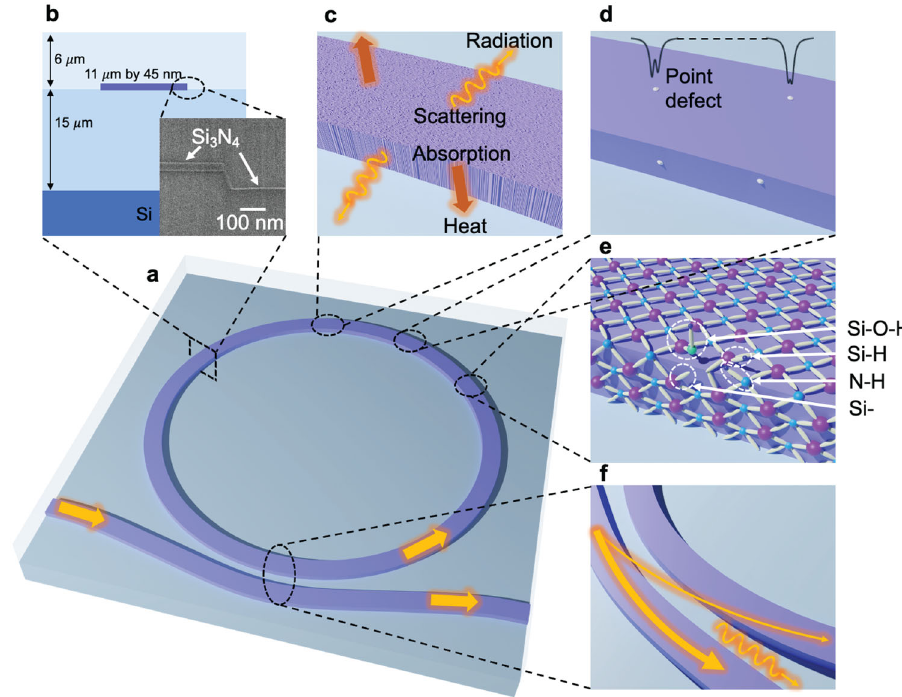
Fig. 1 Bus-coupled ring resonator and loss mechanisms. a Illustration of the resonator design. b Waveguide design. Inset scanning electron micrograph (SEM) image of the waveguide cross section with the thermal oxide bottom cladding, an etched low-pressure chemical vapor deposition (LPCVD) grown silicon nitride waveguide core, an additional thin (~5 nm) blanket layer of silicon nitride (covering the core top and sidewalls), and a tetraethoxysilane pre- cursor plasma-enhanced chemical vapor deposition (TEOS-PECVD) oxide top cladding. SEM length scale bar is 100 nm. c Waveguide surface roughness scatters the guide mode energy into radiation mode and bulk absorption generates heat. d Point defects split resonances. e Defect bonds such as Si – O – H, Si – H, N – H, and dangling bonds lead to surface absorption. f The bus-ring coupler scatters energy into radiation modes and adds excess